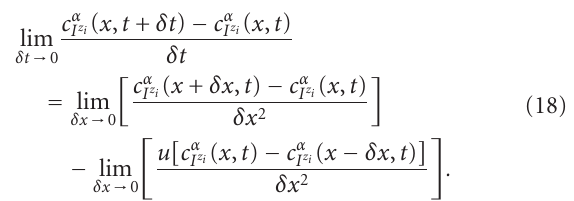
Figure 2: Simulated voltammograms corresponding to the transfer of I z + for di ff erent formal transfer potential values, Δ w o φ o (cid:3) I z + · Δ w o φ o (cid:3) I z + = − 0 . 15 V (red line), 0.00 V (black line) and +0.15V (blue line). Simulation parameters: z = 1, A = 0 . 18 cm 2 , ν = 0 . 050 Vs − 1 , (cid:24) D W D 0 /D W = 1 × 10 − 5 cm 2 s − 1 , ξ = = 1 . 12 (water | 1,2-dichlo- I z + I + I z + roethane system) and c initial I z + = 1 × 10 − 3